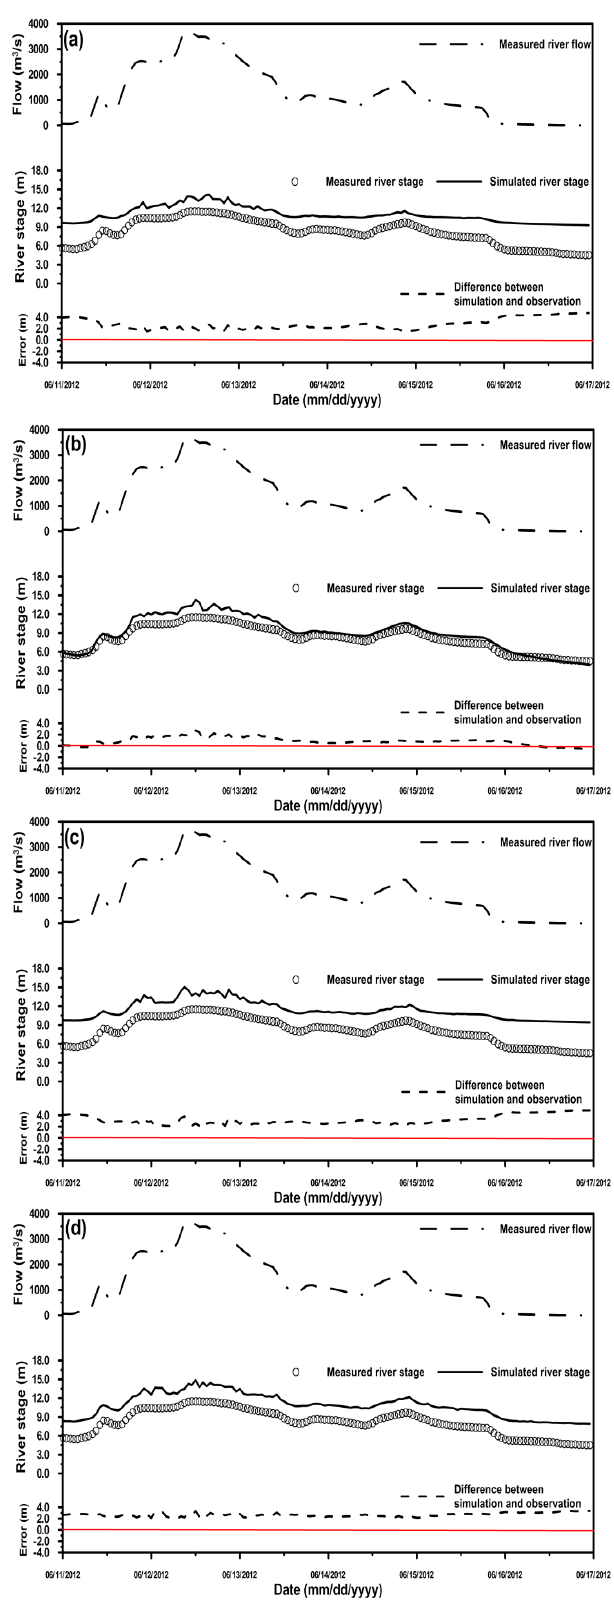
Figure 10. A comparison of the simulated and observed river stages at the Mashan Bridge under the high flow condition using the 2D model with the: ( a ) original cross-section data; and resampled cross- section data according to: ( b ) the linear interpolation method; ( c ) the IDW method; and ( d ) the NN method.